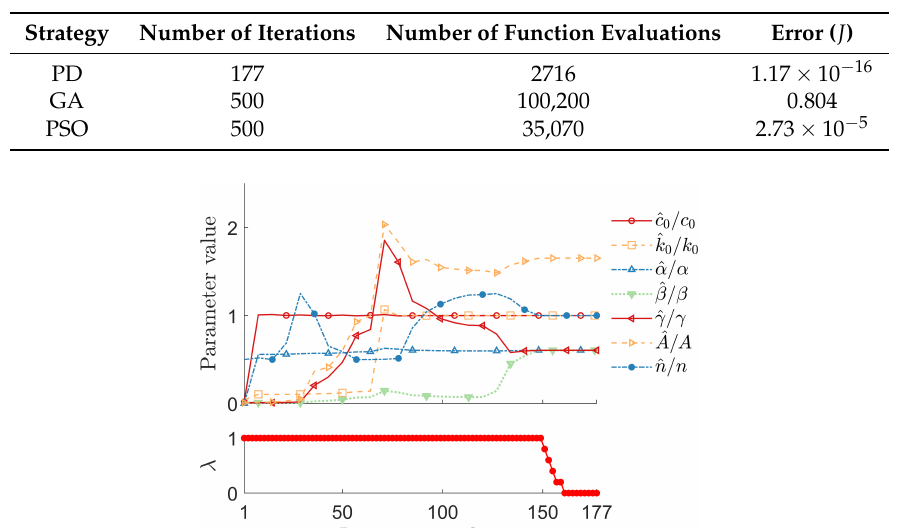
Table 9. Performance of optimization strategies for the magnetorheological damper system using proportional–derivative controller (PD), genetic algorithm (GA), and particle swarm optimization (PSO) approaches.